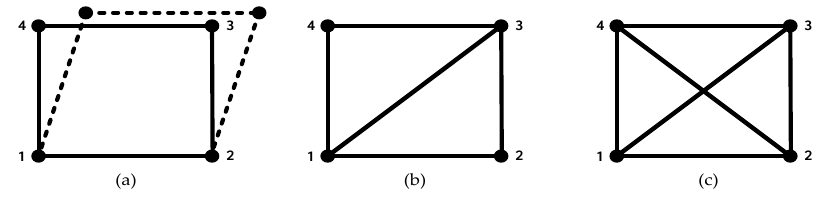
Figure 9. Undirected Frameworks ( a ) Not Rigid ( b ) Rigid ( c ) Globally Rigid